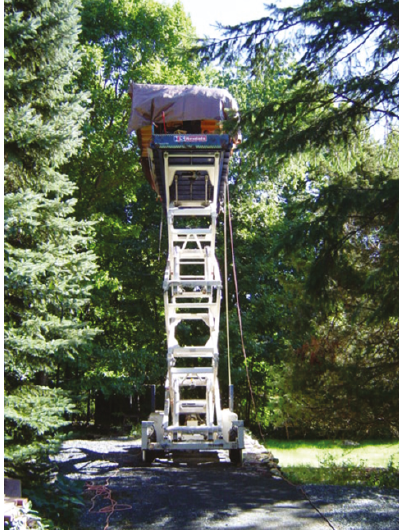
Figure 2: This figure shows the lift with the experiment. The antennas are at the far end of the lift from the viewer under the roof that was built to shield the equipment from the elements. This picture was taken in September with the foliage largely still present. The cables coming from the lift are a ground cable to an earth ground and one of 4 tethers used in windy conditions.